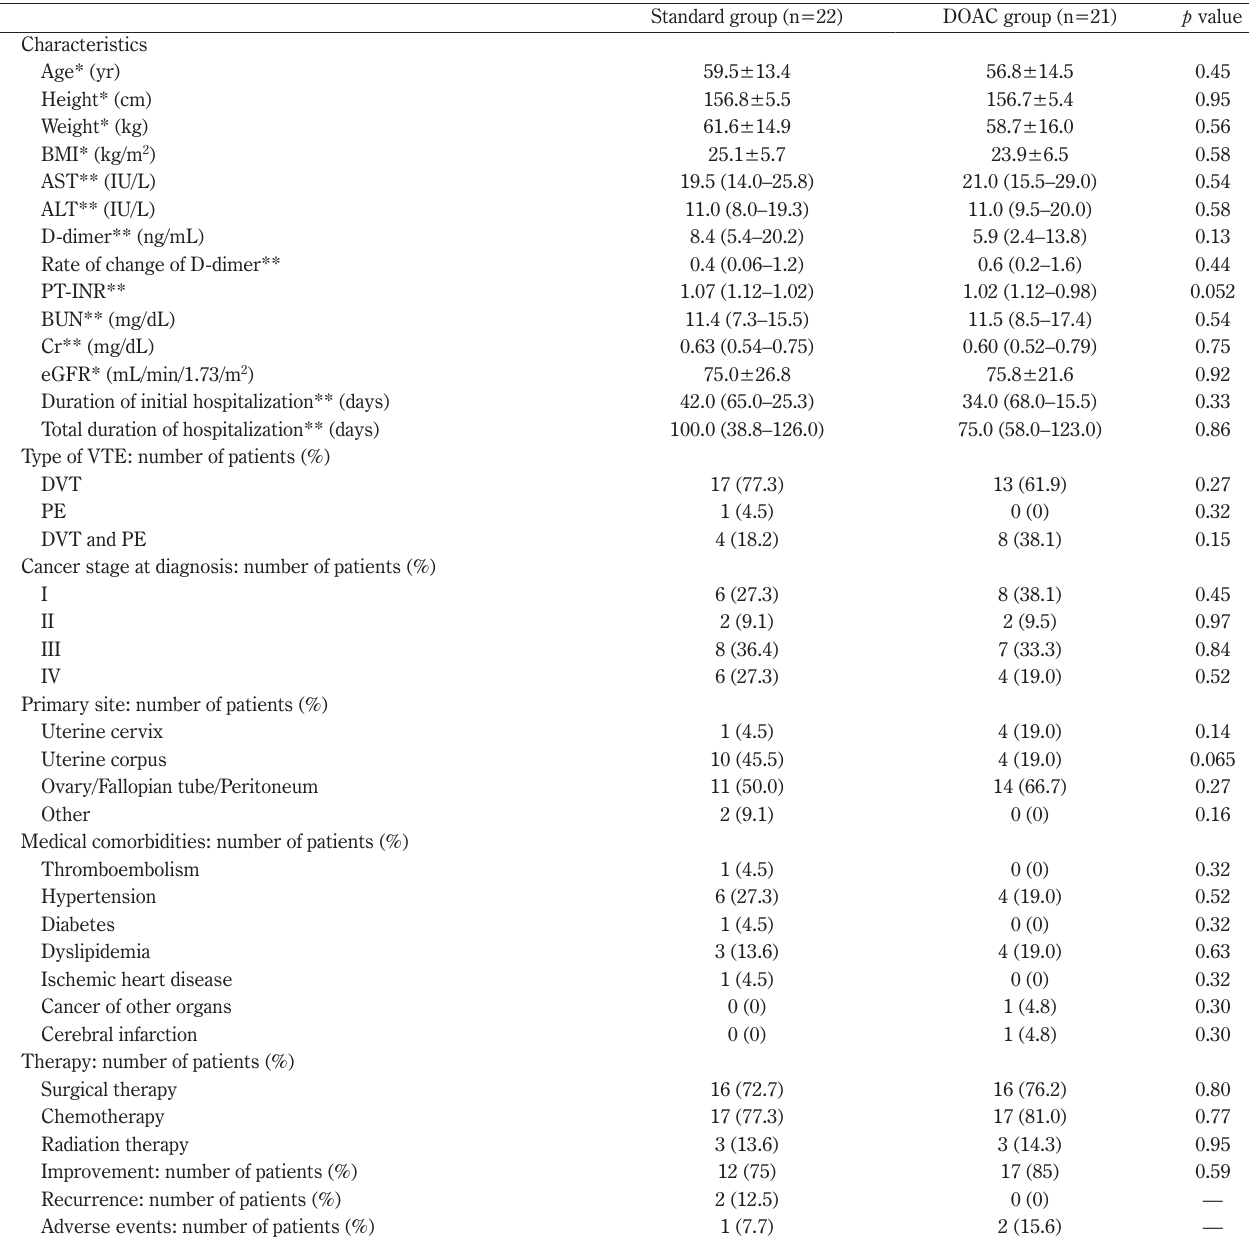
Table 1 Characteristics of the patients and